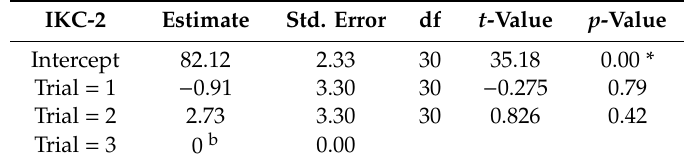
Table 3. Significant di ff erences among mean scores obtained per trial in IKC-2. IKC-2 Estimate Std. Error df t -Value p -Value Intercept